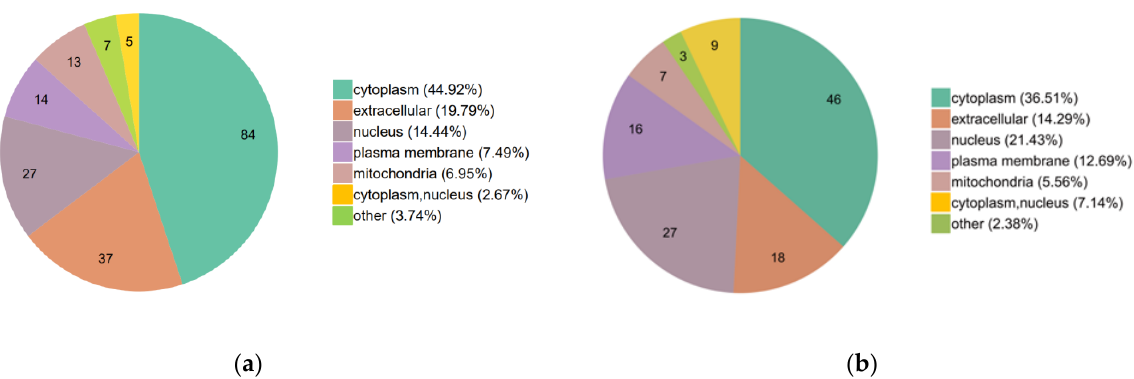
Figure 4. The subcellular localization of the DEPs: ( a ) the subcellular localization of the up-regulated proteins; ( b ) the subcellular localization of the down-regulated proteins.